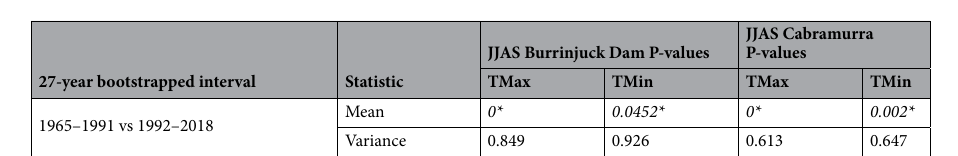
Table 5. P-values from permutation testing differences in JJAS mean maximum. (TMax) and mean minimum (TMin) temperature (C) relative to 27-year bootstrapped intervals for Burrinjuck Dam and Cabramurra (nearby surrogate for Blowering Dam). Significant values (p < 0.05) are italicized with an asterisk.